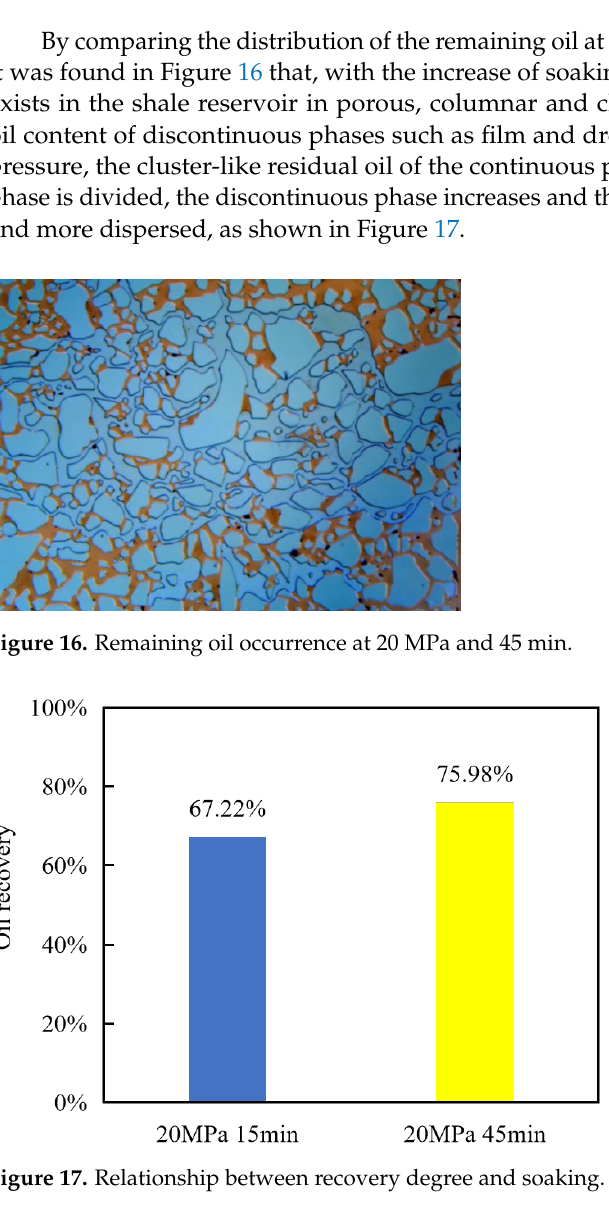
Figure 15. Remaining oil occurrence at 20 MPa and 15 min.